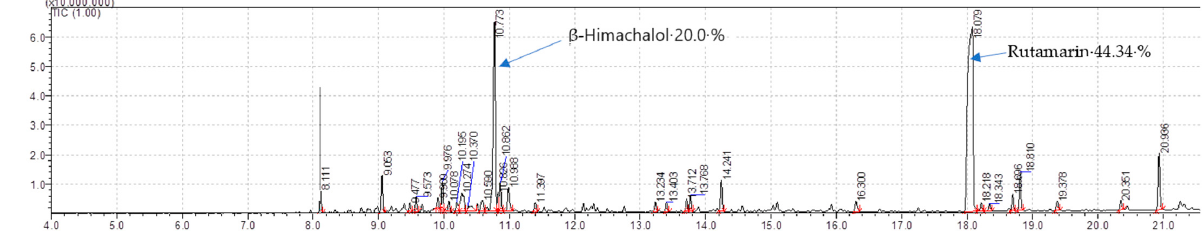
Figure 4. GC-MS/MS Chromatogram of isolated non-volatile oil A of root bark of T. ciliata.